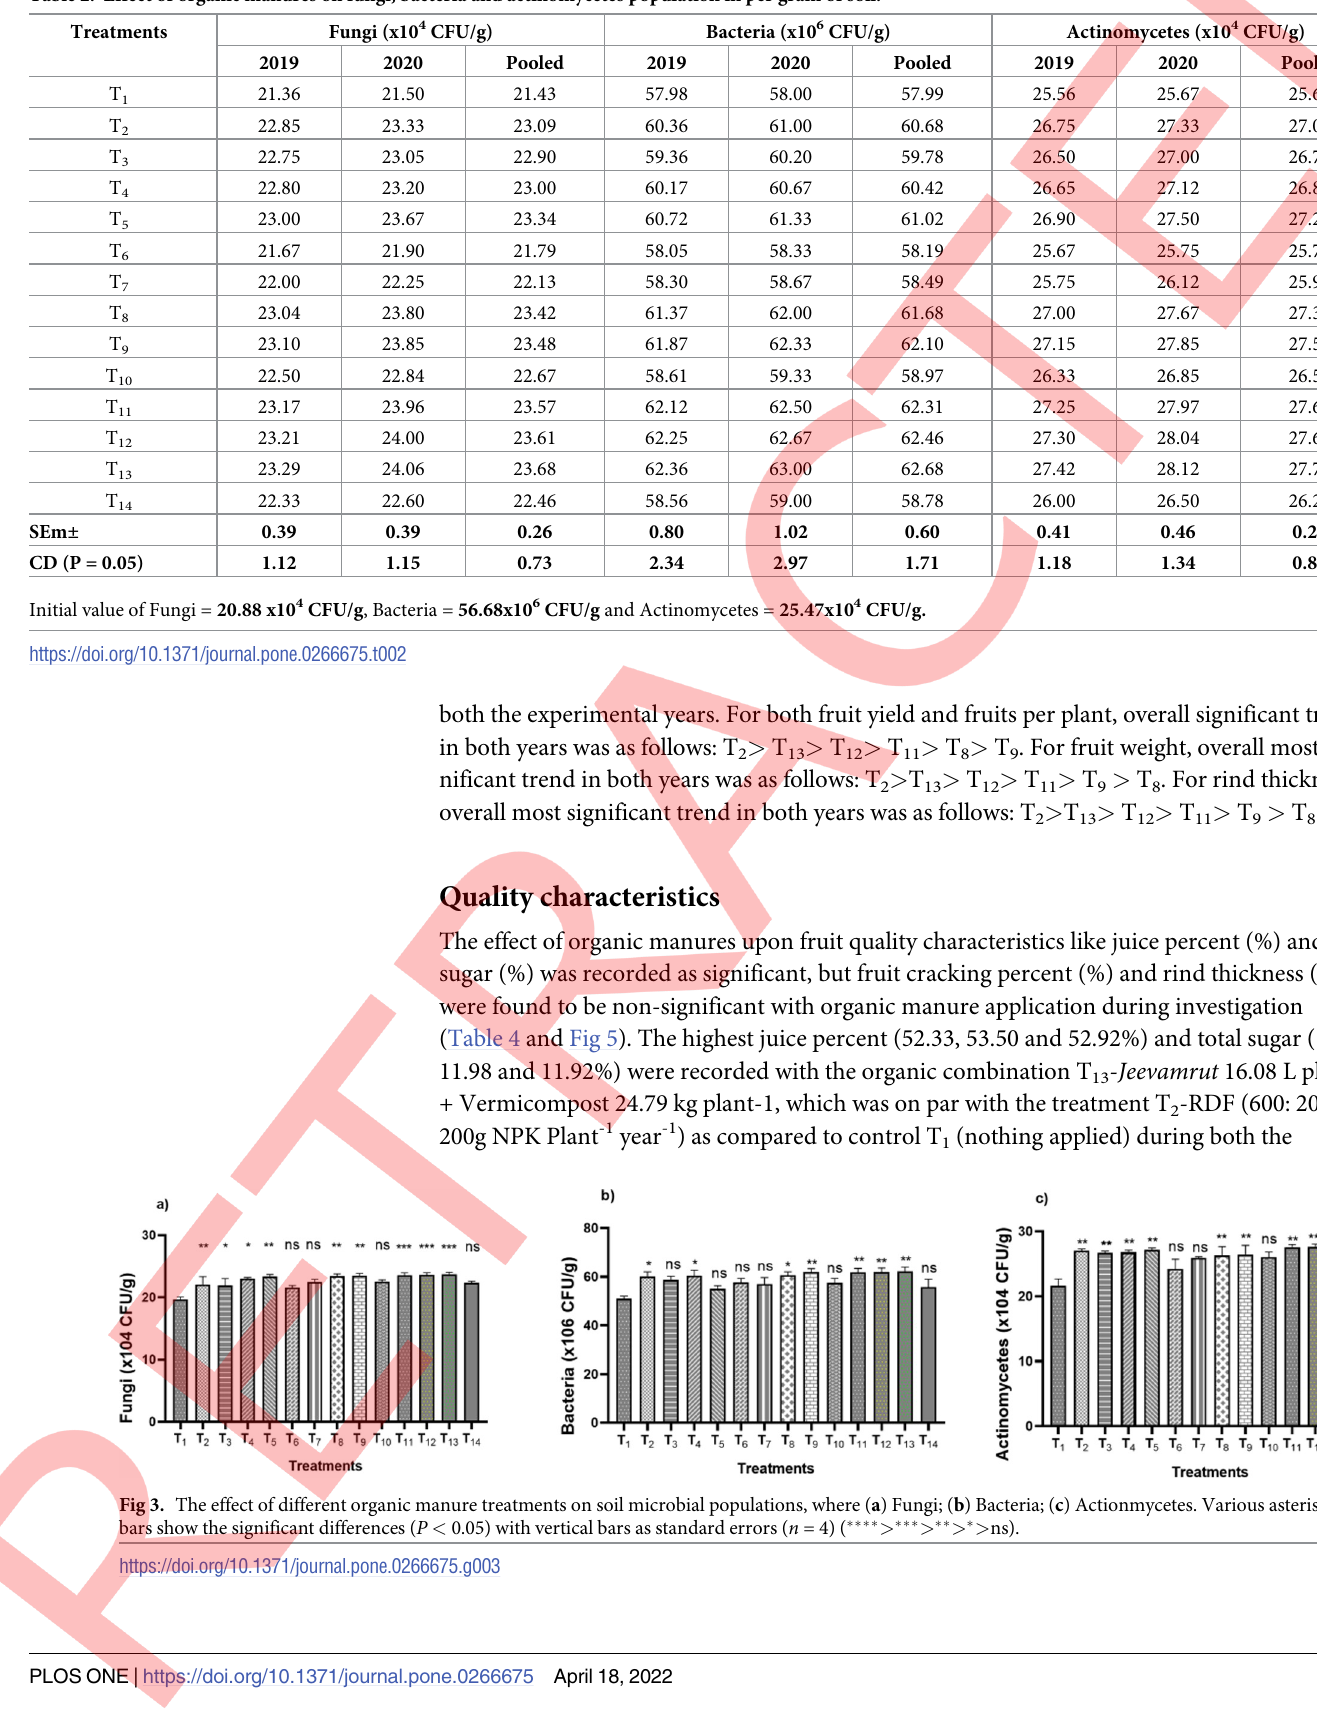
PLOS ONE | https://doi.org/10.1371/journal.pone.0266675 April 18,